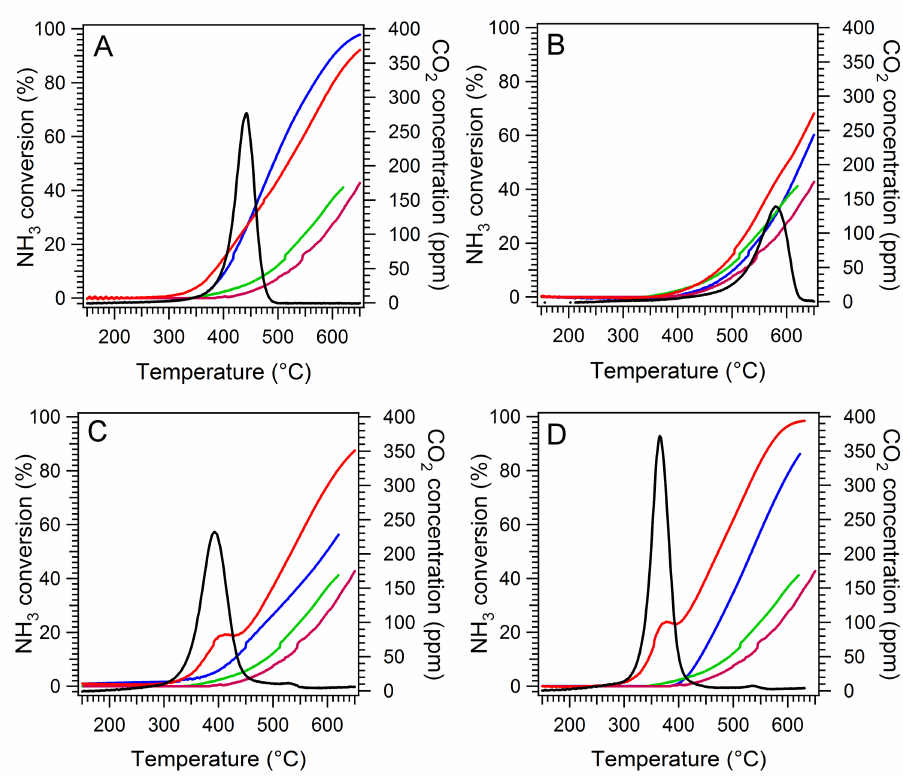
Figure 8. NH 3 oxidation carried out on single catalyst components and/or soot under the following conditions: catalyst 20 mg, NH 3 500 ppm, O 2 10%, N 2 balance, GHSV 900,000 h − 1 . Magenta lines: NH 3 conversion curve over empty reactor; green lines: NH 3 conversion curve of bare soot; blue lines: NH 3 conversion curve over catalyst ( A ) FeVO 4 —( B ) TWS—( C ) CeO 2 —( D ) Ce 0.75 Zr 0.25 O 2 , red lines: NH 3 conversion over catalyst in tight contact with soot, black lines: CO 2 released during